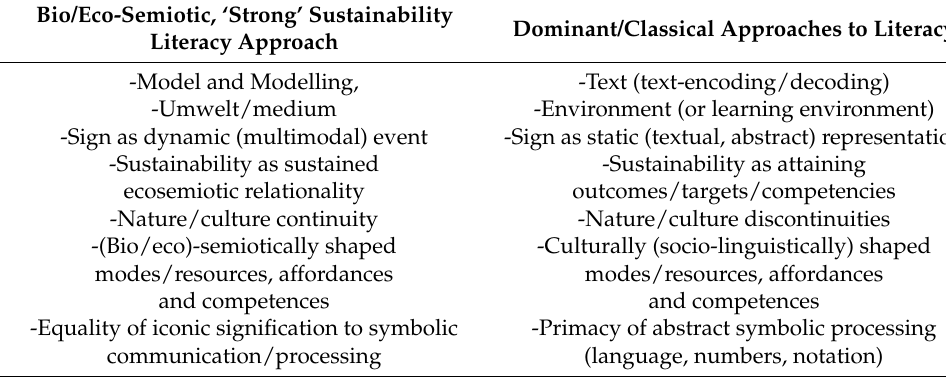
Table 2. Sustainability literacy: conceptual realignments and expansion in the domain of literacy. Bio/Eco-Semiotic, ‘Strong’ Sustainability Dominant/Classical Approaches to Literacy Literacy Approach -Model and Modelling, -Text (text-encoding/decoding) -Umwelt/medium -Environment (or learning environment) -Sign as dynamic (multimodal) event -Sign as static (textual, abstract) representation -Sustainability as sustained -Sustainability as attaining ecosemiotic relationality outcomes/targets/competencies -Nature/culture continuity -Nature/culture discontinuities -(Bio/eco)-semiotically shaped -Culturally (socio-linguistically) shaped modes/resources, affordances modes/resources, affordances and competences and competences -Equality of iconic signification to symbolic -Primacy of abstract symbolic processing communication/processing (language, numbers,